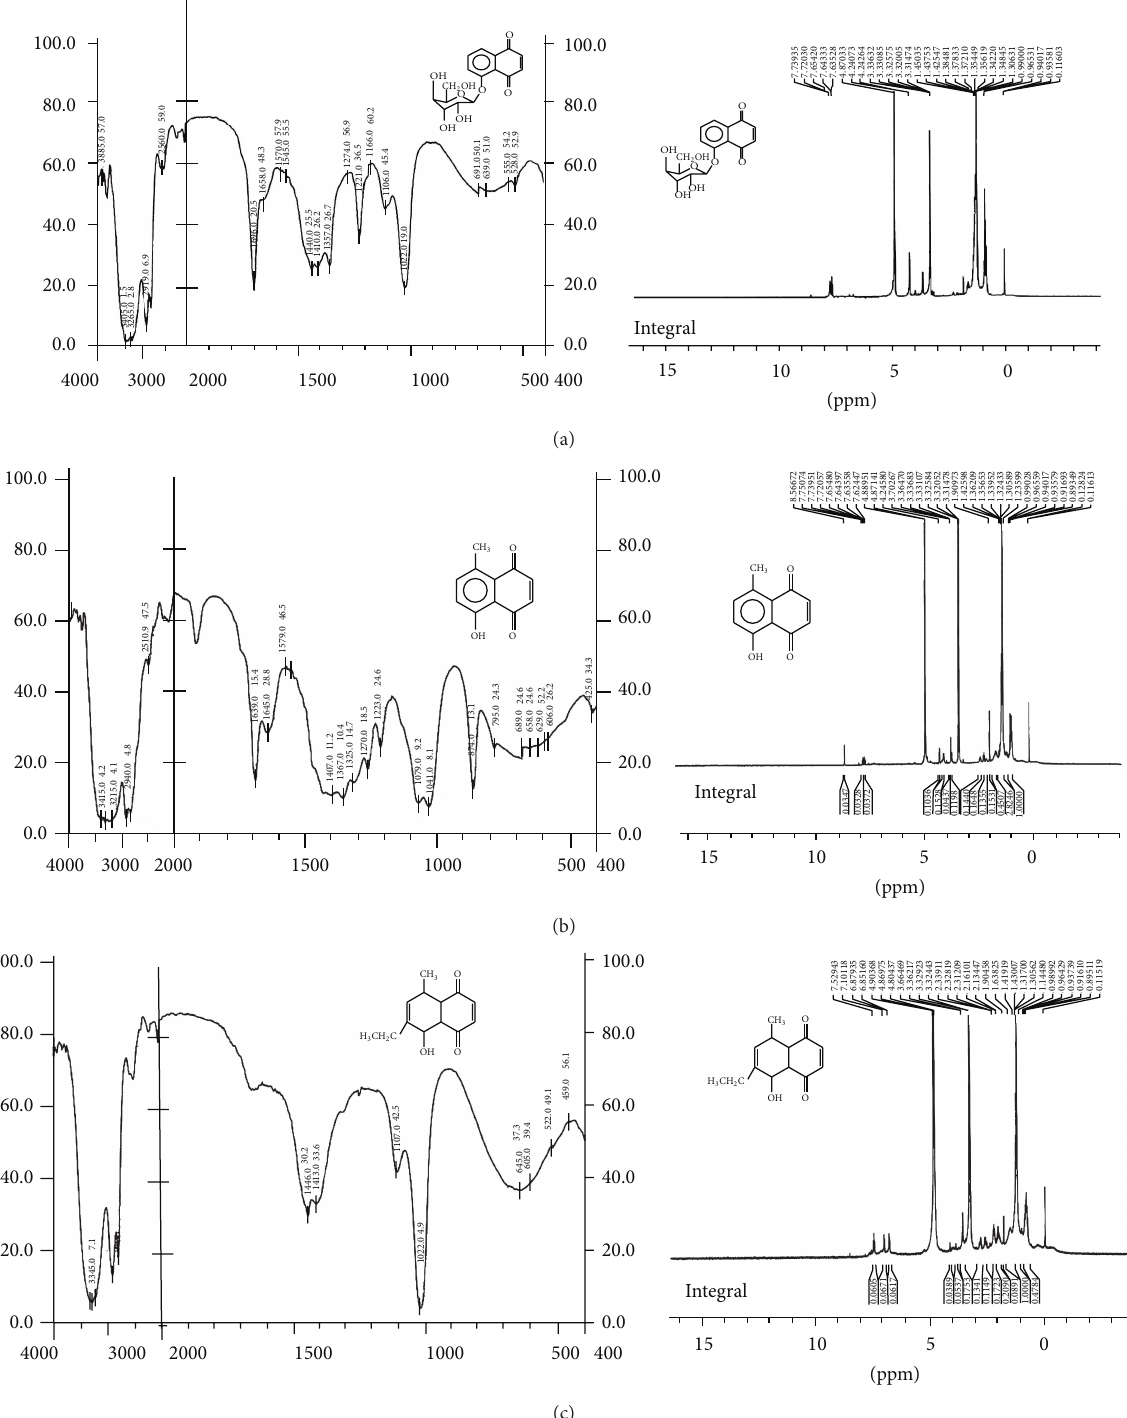
Figure 1: IR and NMR spectra from the extracted dye: (a) 𝑛 -hexane/petroleum ether (90:10, v/v), 𝑅 𝑓 = 0.32 , (b) petroleum ether/diethyl ether (50 :50, v/v), 𝑅 𝑓 = 0.68 , and (c) petroleum ether/diethyl ether (55:45, v/v), 𝑅 𝑓 = 0.64